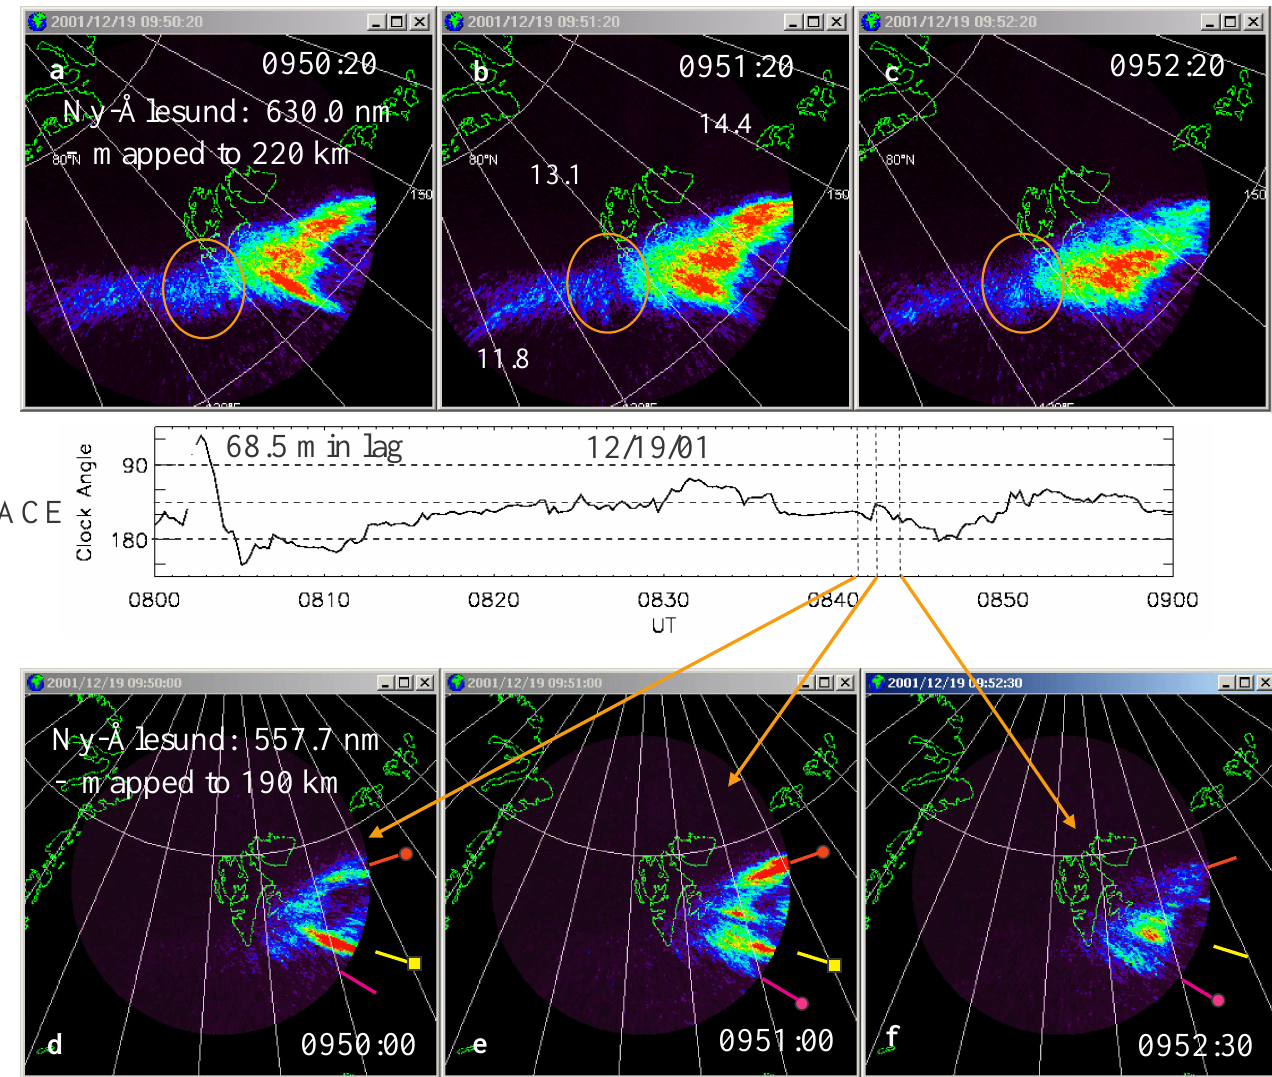
Fig. 8. 630.0-nm images (top) compared with the corresponding 557.7-nm images (bottom). The 557.7-nm images are the same as those in Figs. 6d, 6e, and 6f. The 630.0-nm images are in magnetic coordinates with the central meridian passing through Ny- ˚Alesund and two other meridians labeled with MLT. The orange circles in the top three images mark breaks in emissions between source regions.